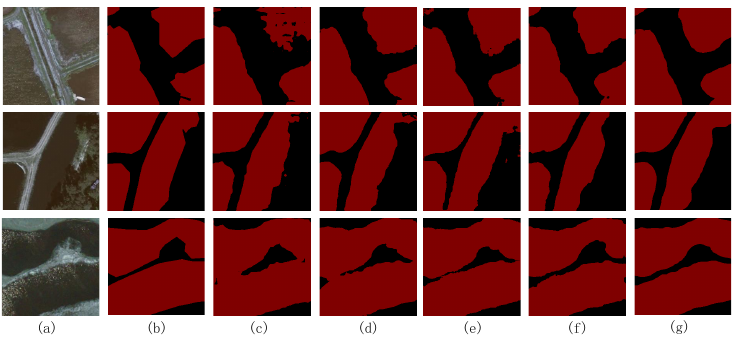
Figure 14. ( a ) Image; ( b ) label; ( c ) DenseASPP; ( d ) Unet; ( e ) MSRNet; ( f ) Deeplapv3+; ( g ) Our